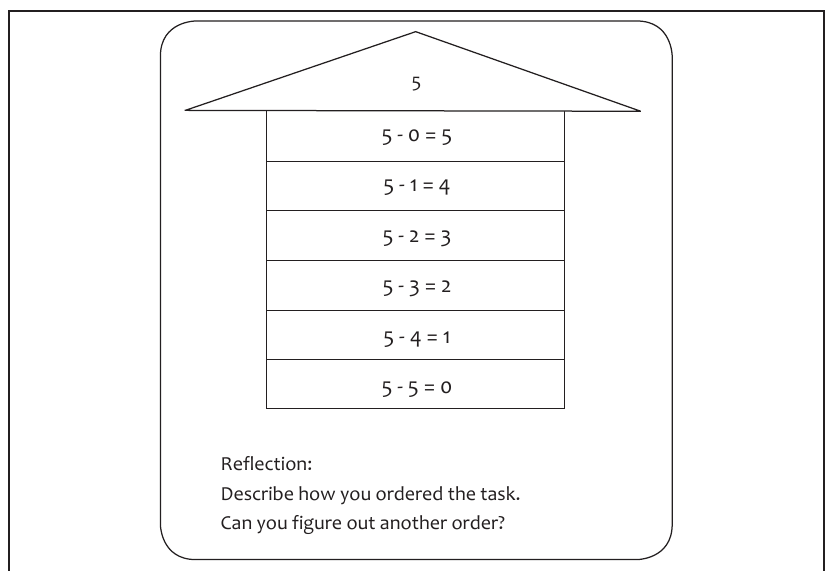
Figure 10: Introducing